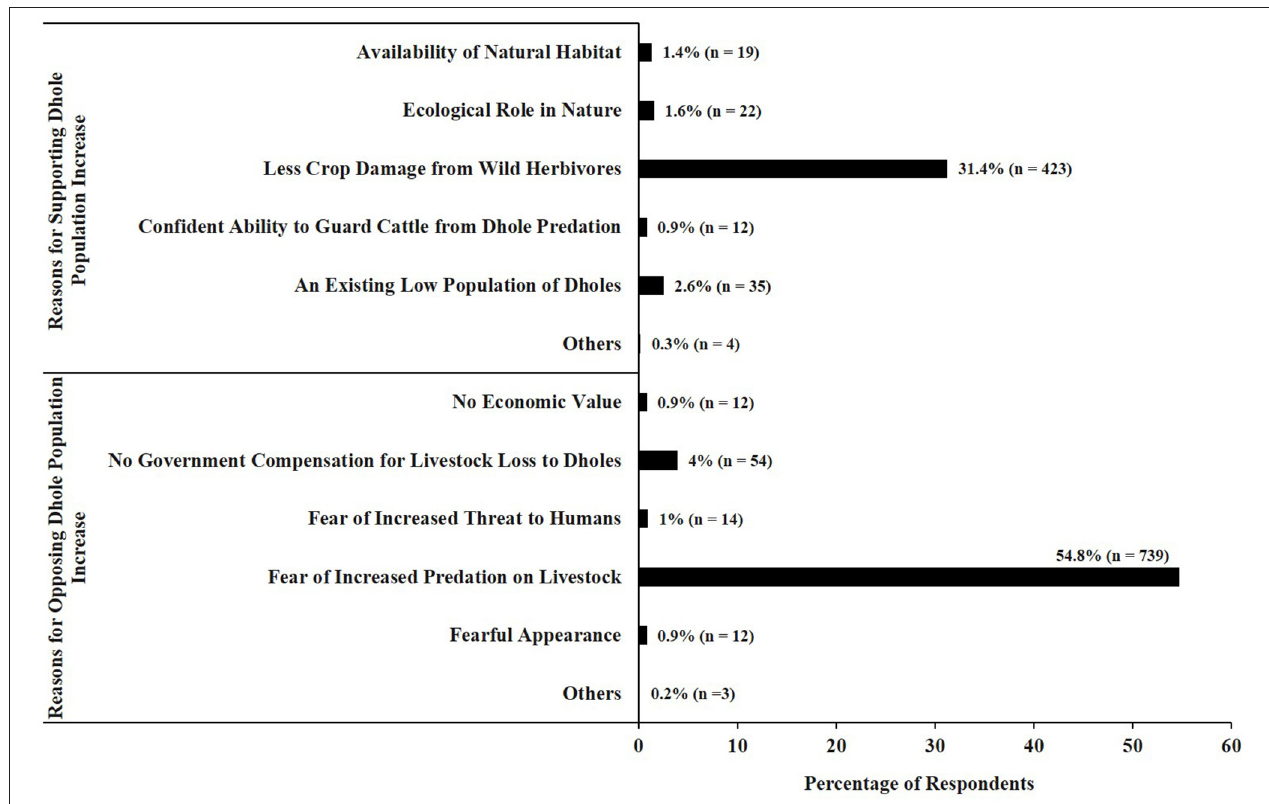
FIGURE 3 | Reasons for supporting and opposing dhole ( Cuon alpinus ) population increase in Bhutan and the corresponding number of respondents from a questionnaire survey of local people in four regions from September to November